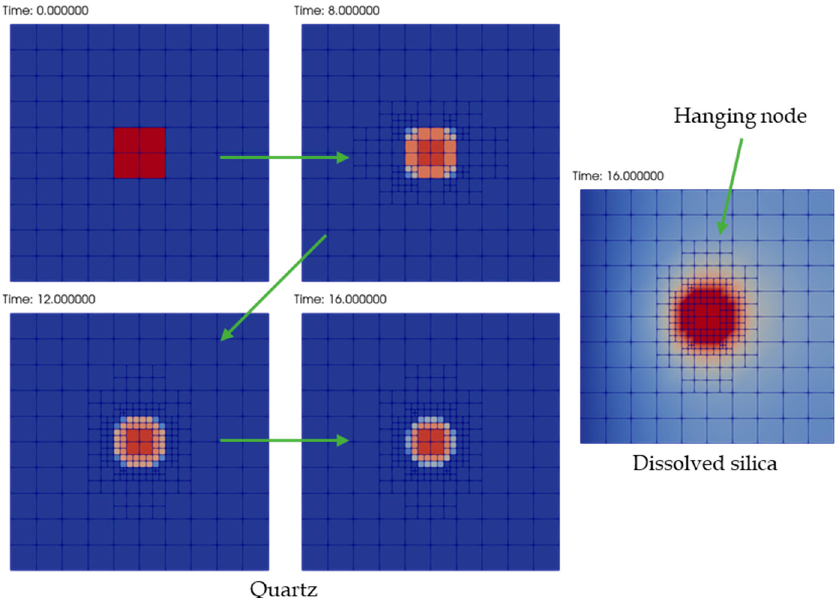
Figure 2. Adaptive refinement around a square quartz region in a low silica concentration domain. A fixed low concentration silica source is present at the left boundary. The left-most four plots show how refinement and coarsening at successive times leads to more plausible shapes of alteration of the quartz block than would be obtained with a fixed grid. The corresponding silica solute concentration at the final time is shown in the right-hand plot. An example hanging node is also noted.